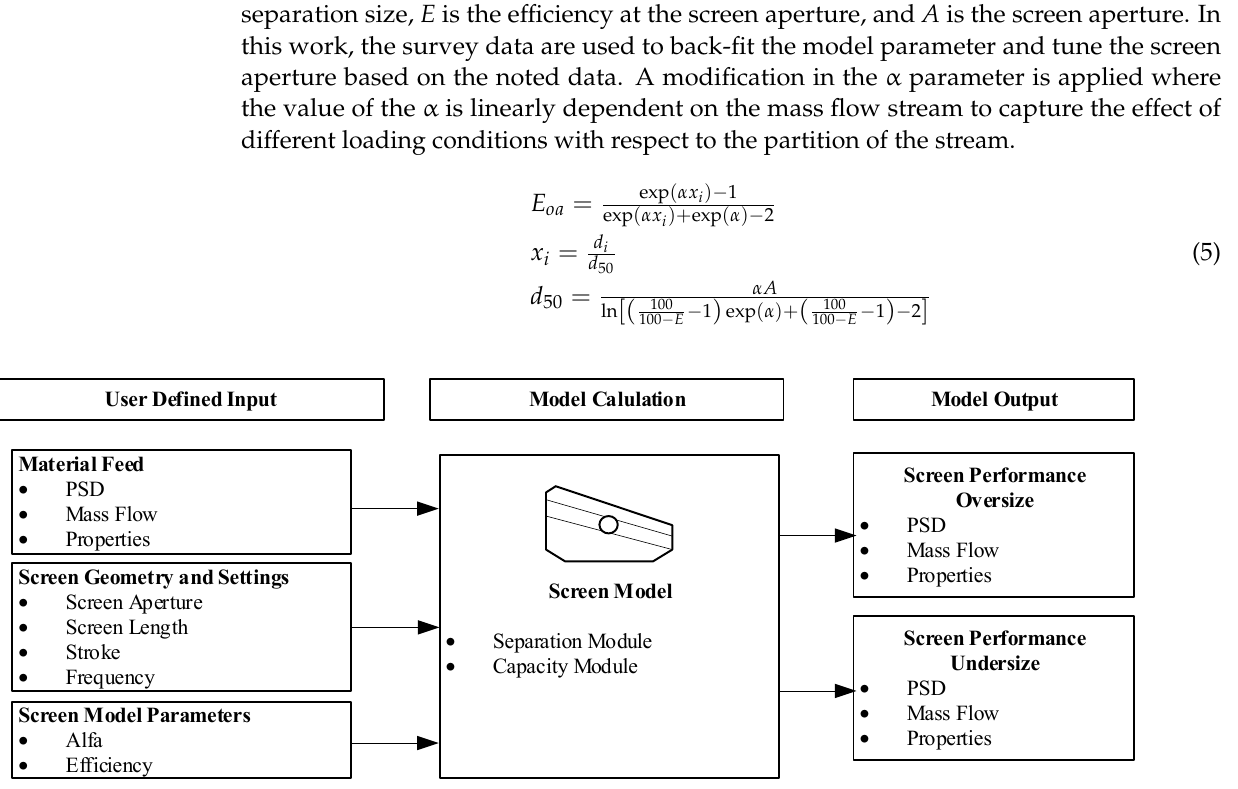
Figure 5. Overview of the screen model implemented in Matlab/Simulink environment.